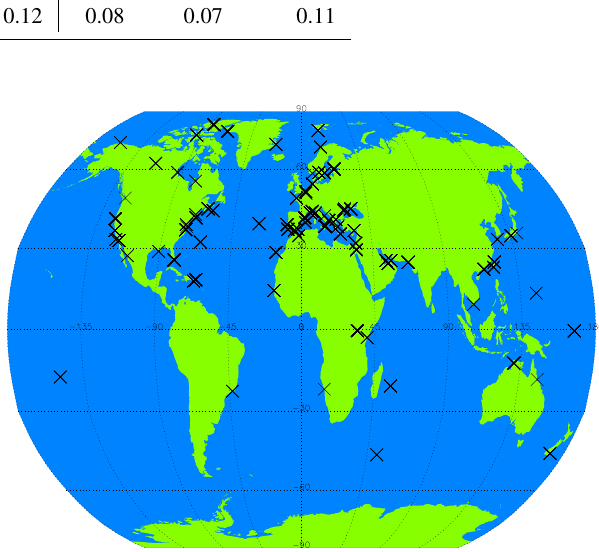
Figure 7. Map of the 93 coastal/island AERONET sites with level 2.0 data for the 2007–2008 and 2010–2011 periods, used for collo- cation with over-ocean CALIOP aerosol